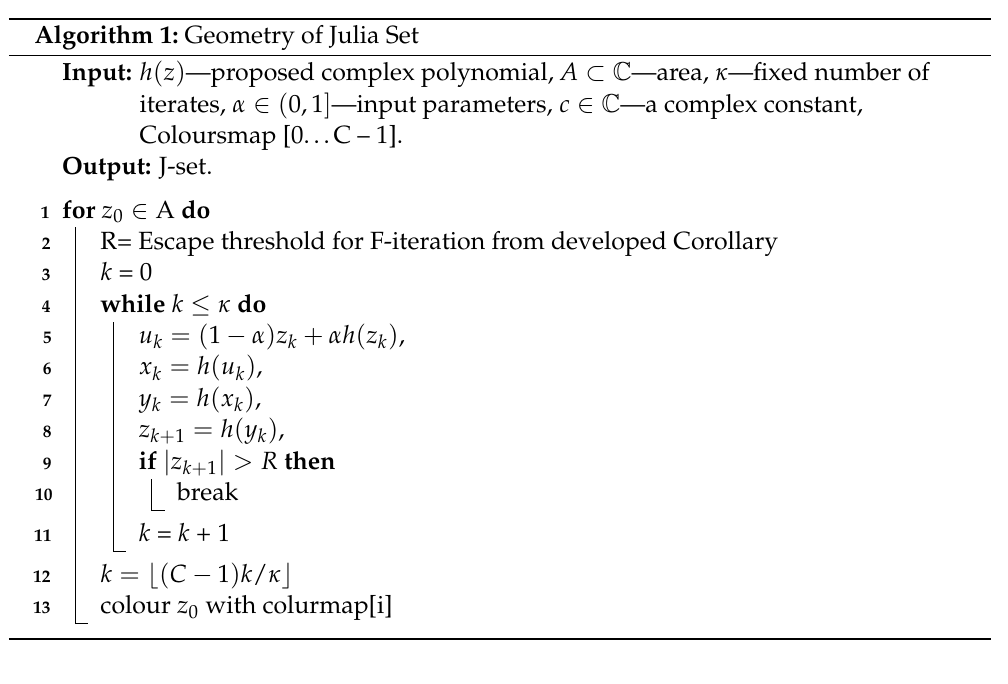
Algorithm 2: Geometry of